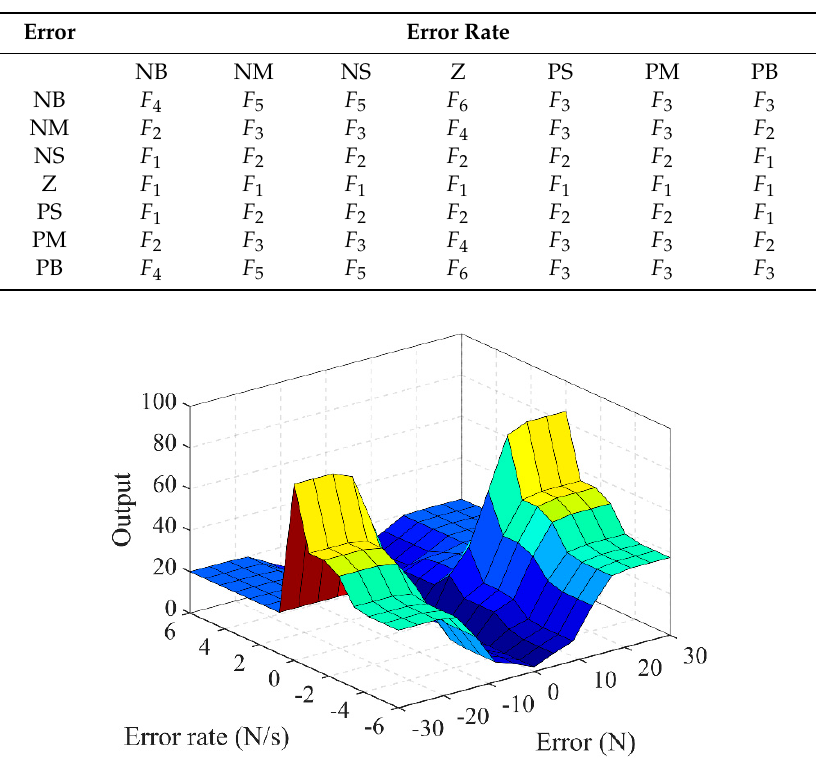
Figure 13. Control surface of the fuzzy logic controller.